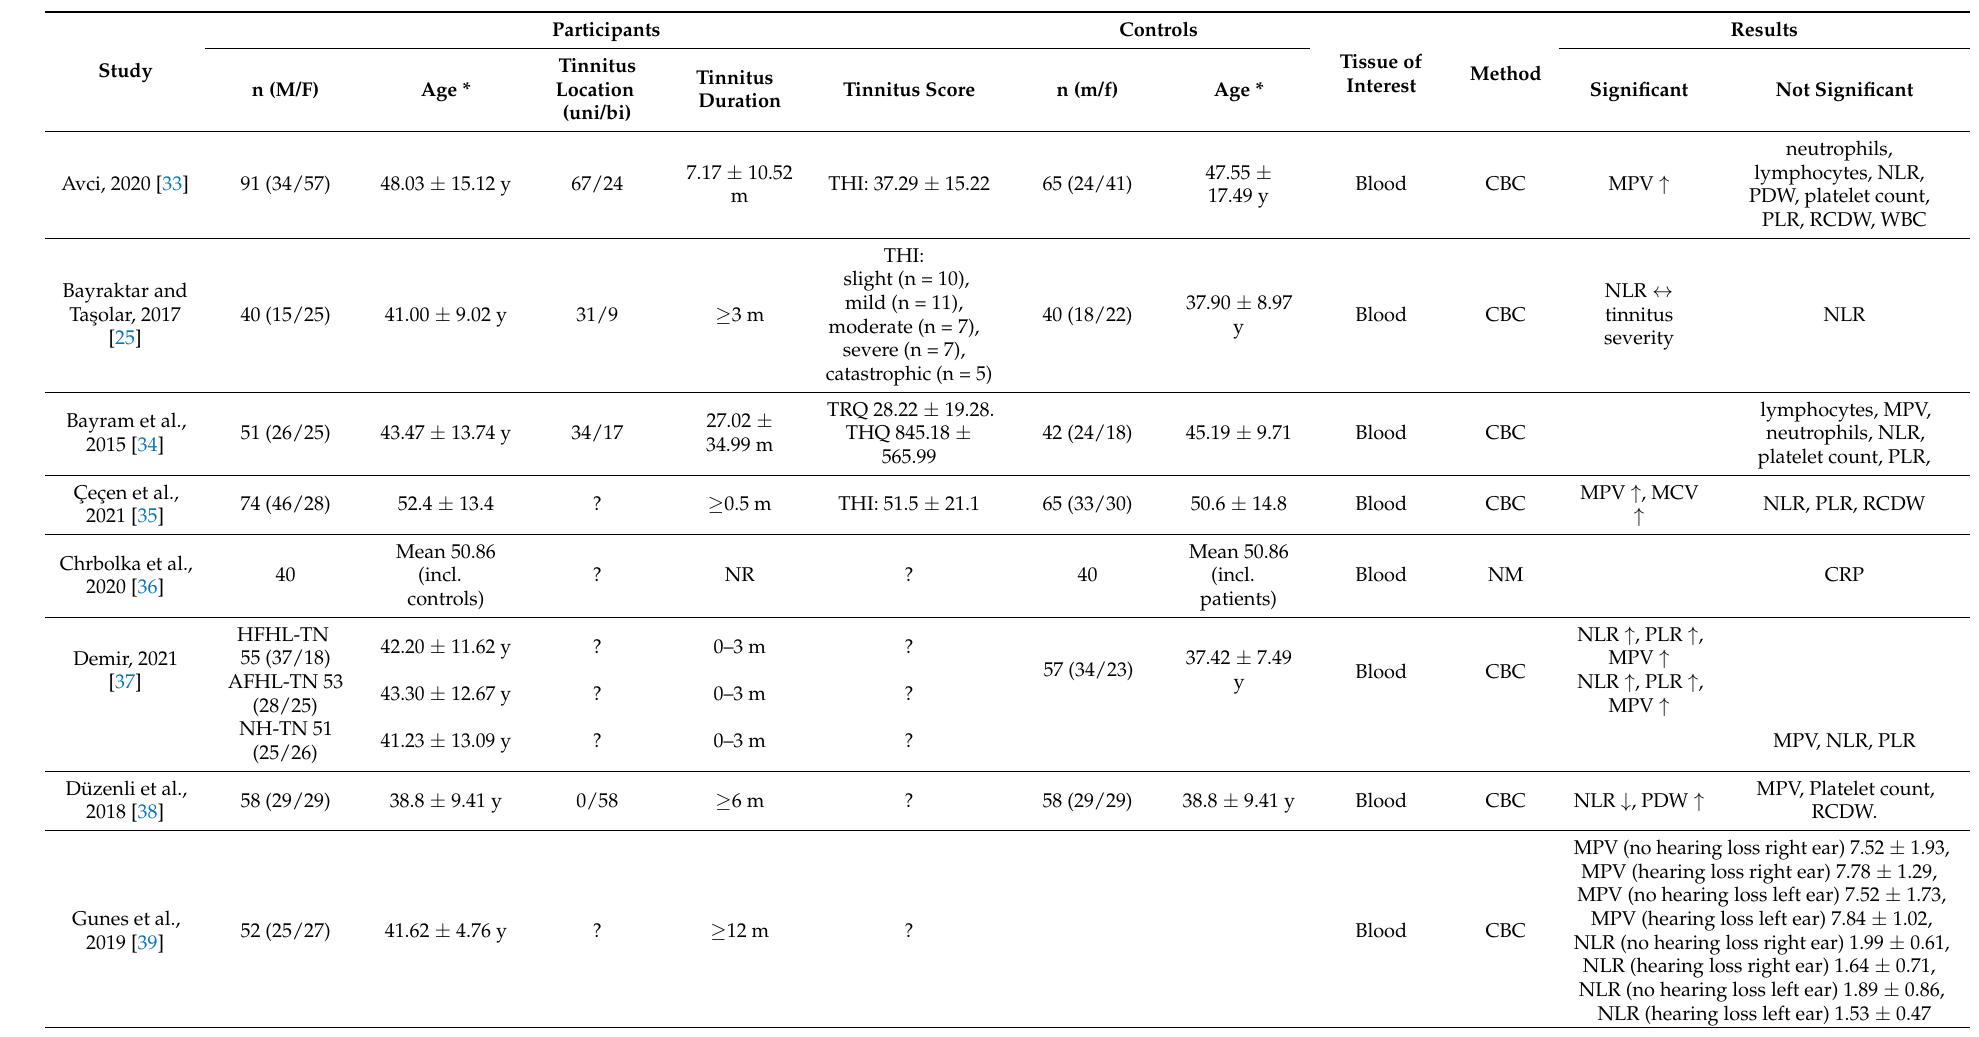
Table 2. Human studies assessing inflammatory markers in tinnitus. * Reported in mean ± SD unless otherwise